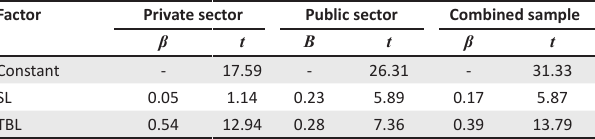
FIGURE 2 : Mediation effect of team-based learning on the relationship between servant leadership and hope and optimism.